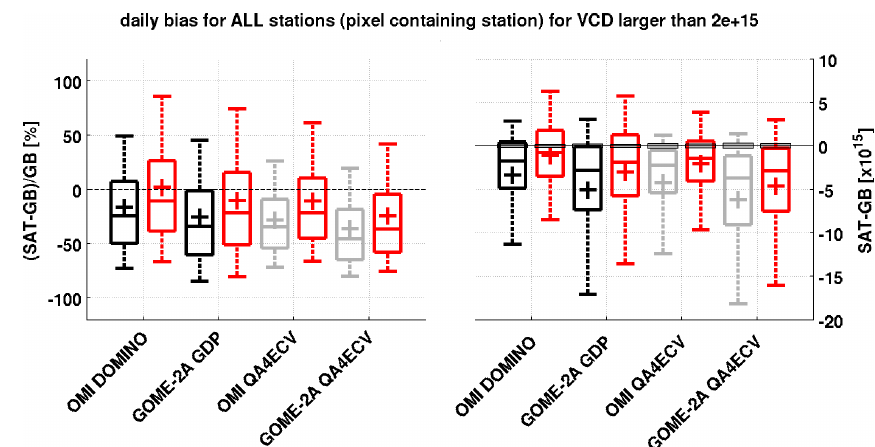
Figure 16. Box-and-whisker plot of the daily satellite biases for all stations together, in absolute and relative values. The box-and-whisker plots are defined as in Fig. 7. Red is used for the dilution-corrected data, while black is used for the previously presented products (OMI DOMINO and GOME-2A GDP), and grey is used for the QA4ECV